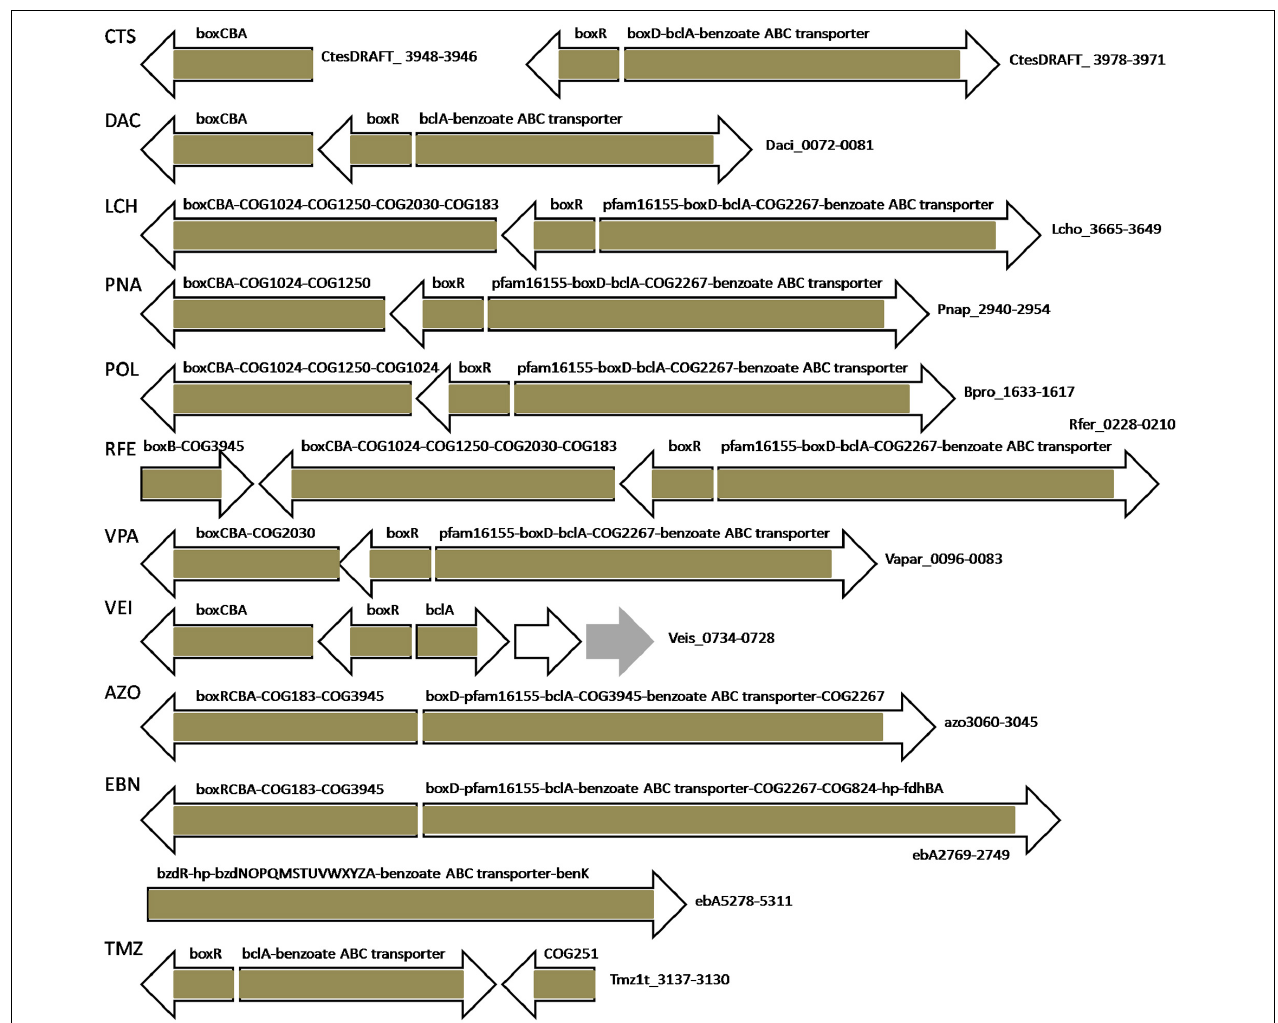
FIGURE 7 | Operon organization and regulation of aromatic metabolism genes regulated by BoxR/BzdR in other studied Betaproteobacteria. Brown color denotes regulation by BoxR/BzdR. Genes/operons are shown by arrows, gray arrows denote transposases; “hp” indicates hypothetical proteins. Genome abbreviations as in Supplementary Table S2